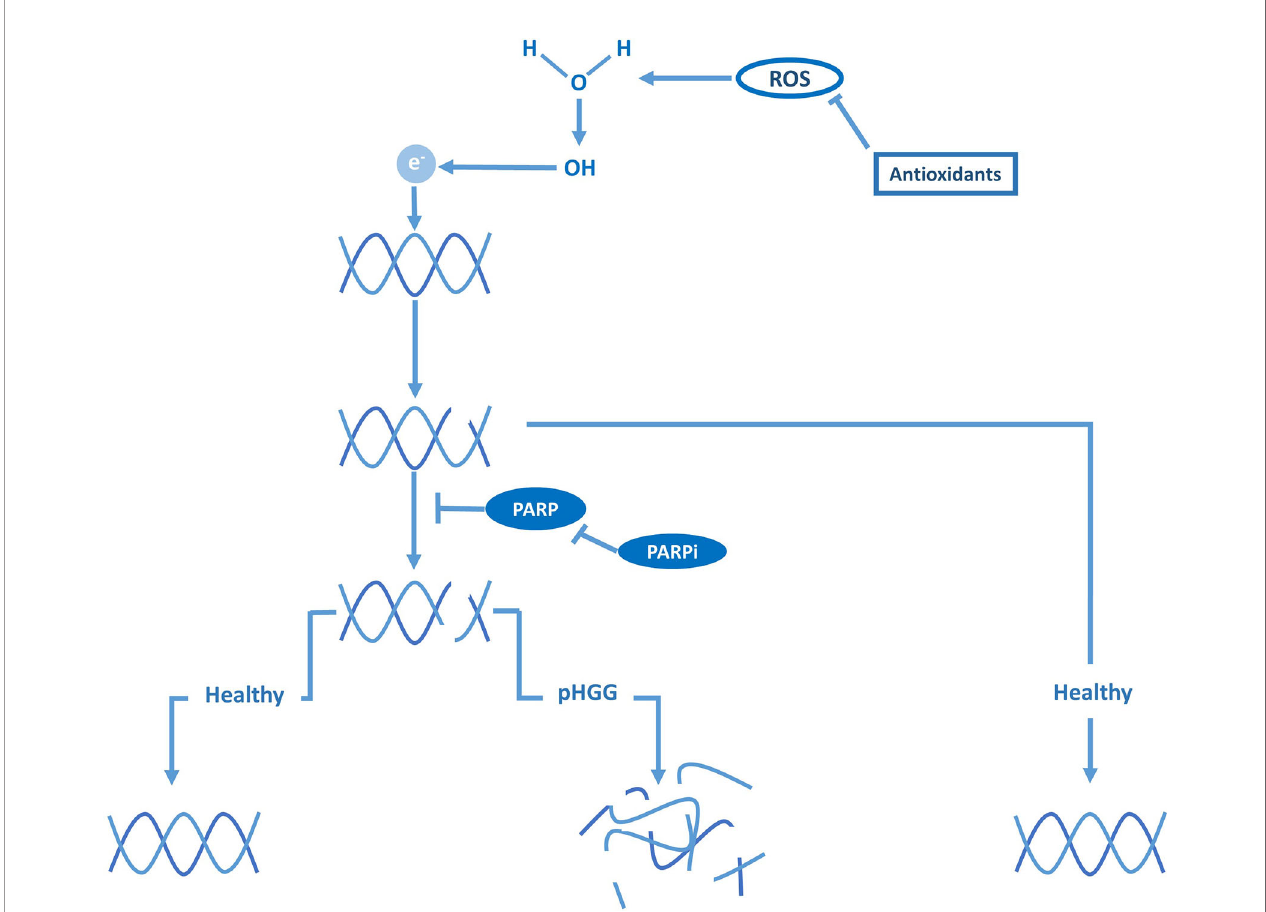
FIGURE 3 | DNA damage repair and PARP are vital against ROS-induced DNA breaks in